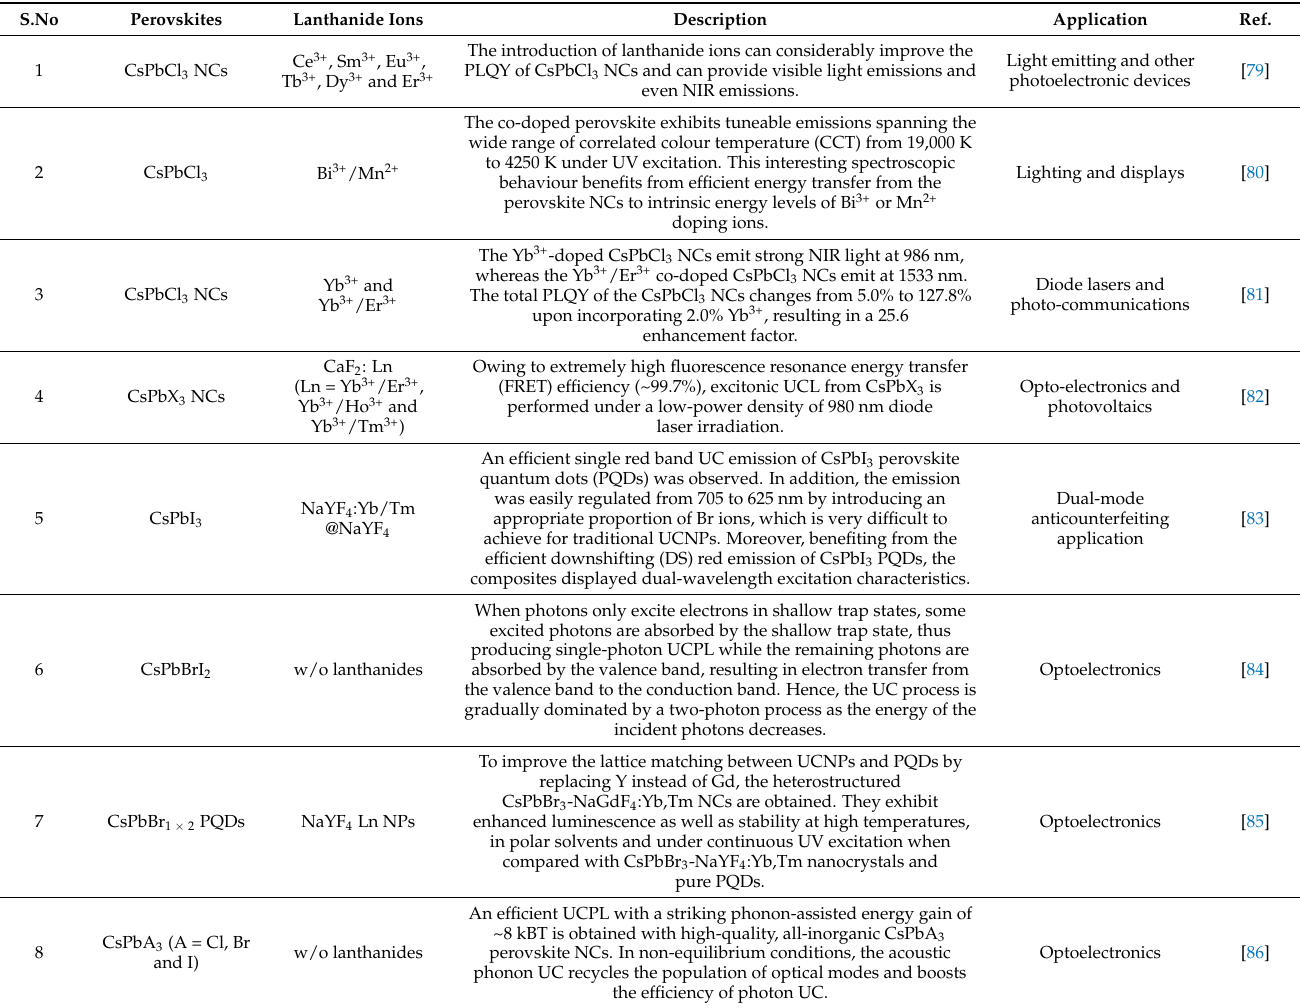
Table 1. Lanthanide-doped inorganic halide perovskite NCs and non-doped perovskites for various